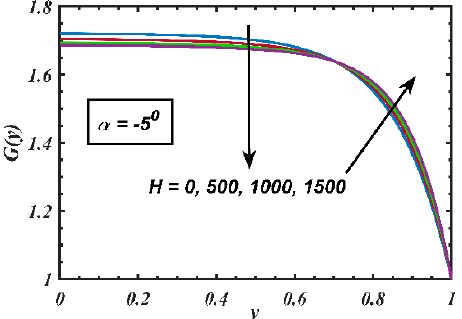
Figure 10. Variation of G(y) in converging channel for α = 0 0 , − 1 0 , − 3 0 , − 5 0 and H = 0, Re = 100, Pr = 5, Ec = 0.5.